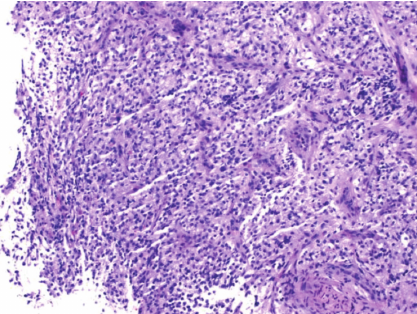
Figure 1: Neonate soon after birth: physical exam suggestive of mas- sive ascites.